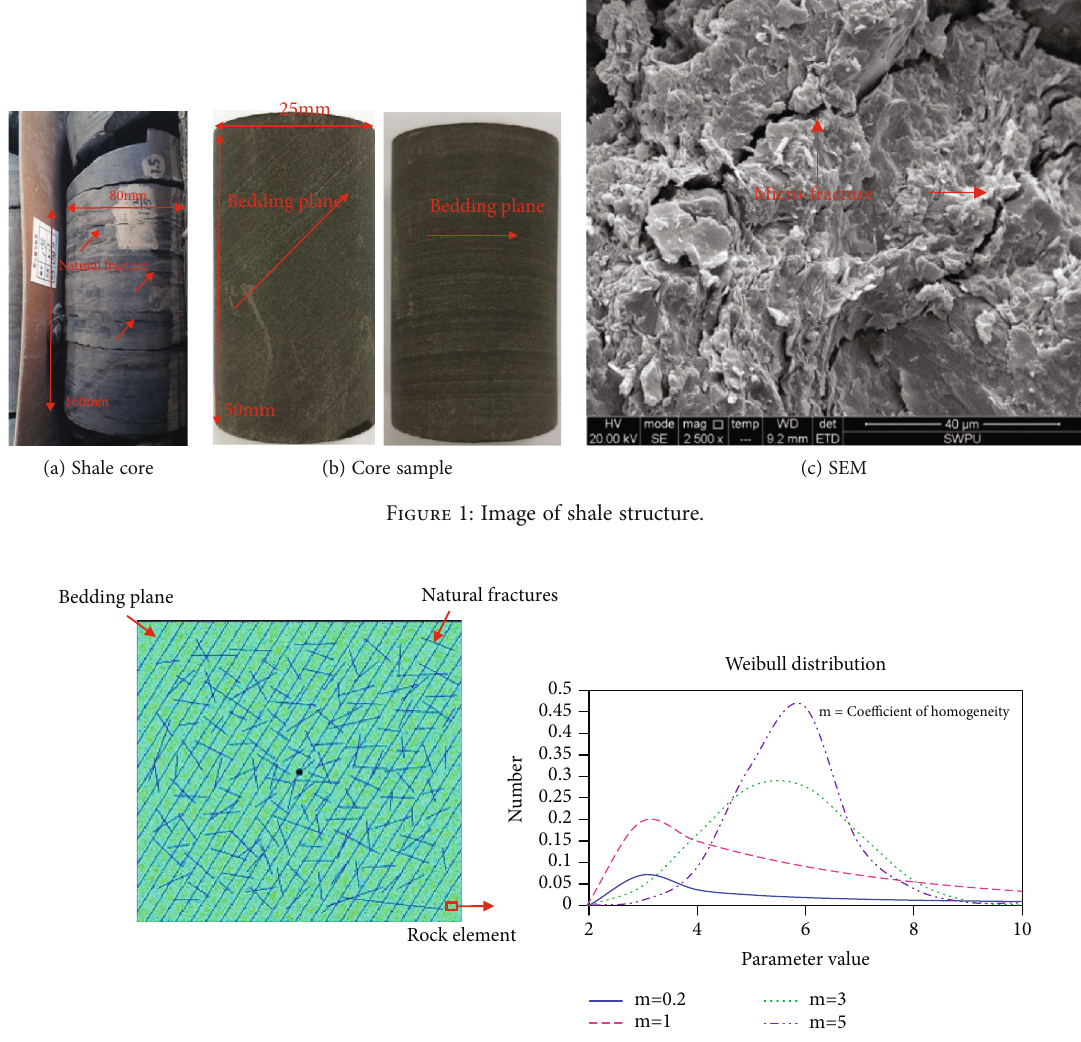
Figure 2: Anisotropy of shale formation in RFPA